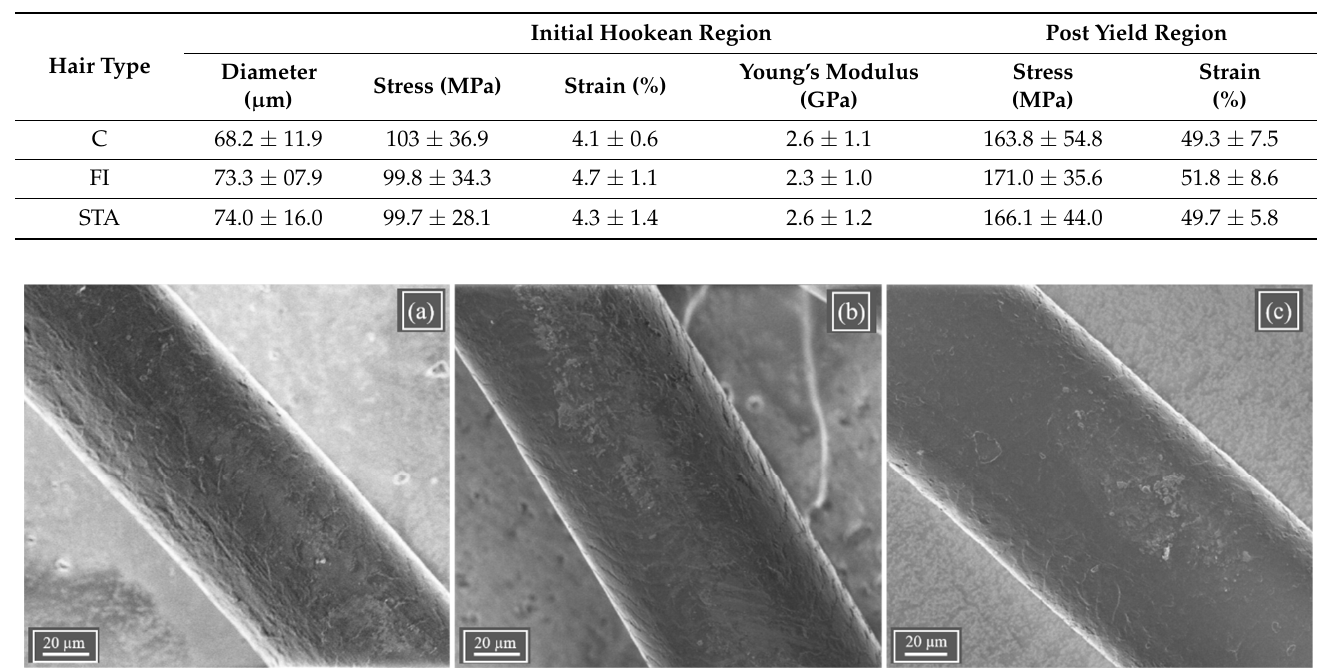
Figure 6. SEM images of ( a ) C, ( b ) FI, and ( c ) STA hair.